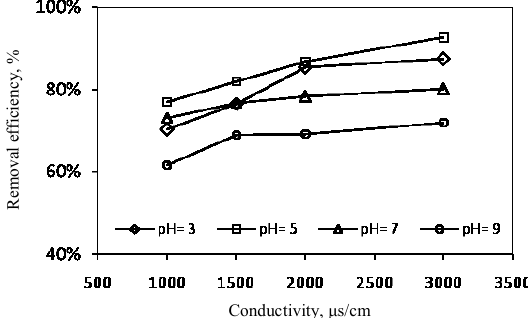
Figure 8. Effect of conductivity on the HA removal efficiency as a function of pH (initial concentration of HA: 20 mg L -1 , reaction time: 75min, applied voltage: 50 V).